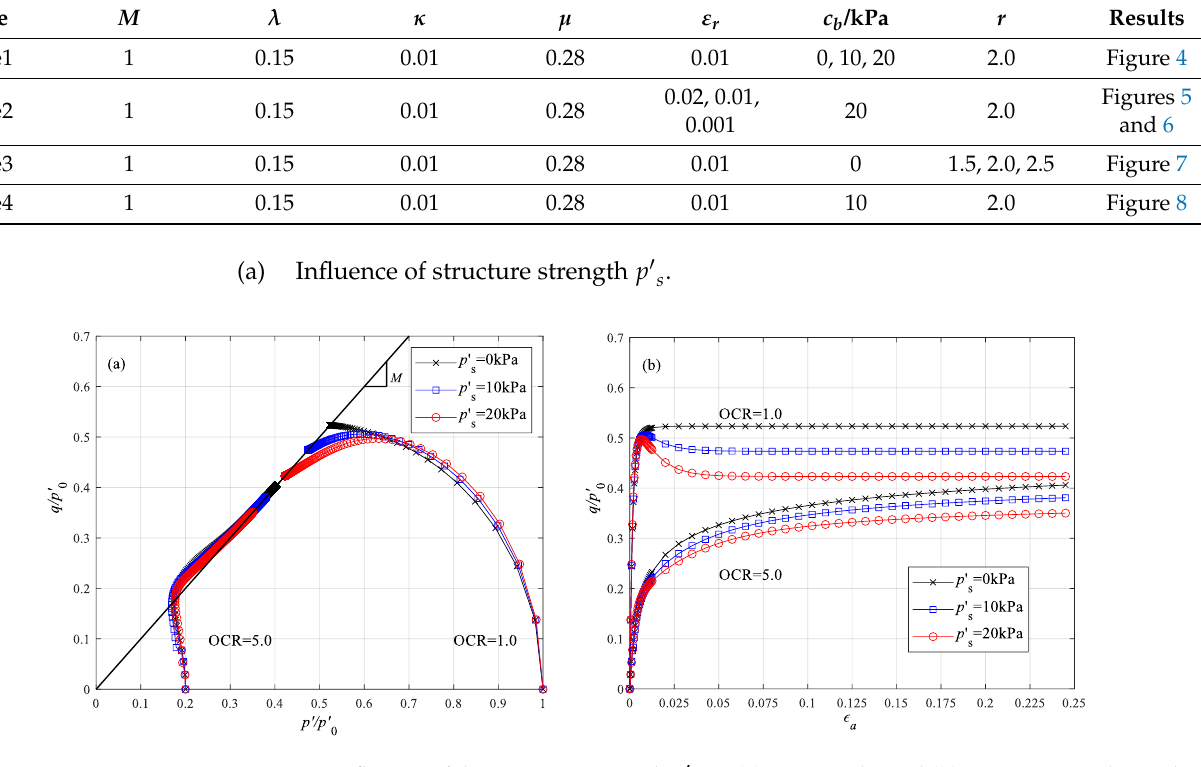
Figure 4. Influence of the structure strength p (cid:48) s ships.